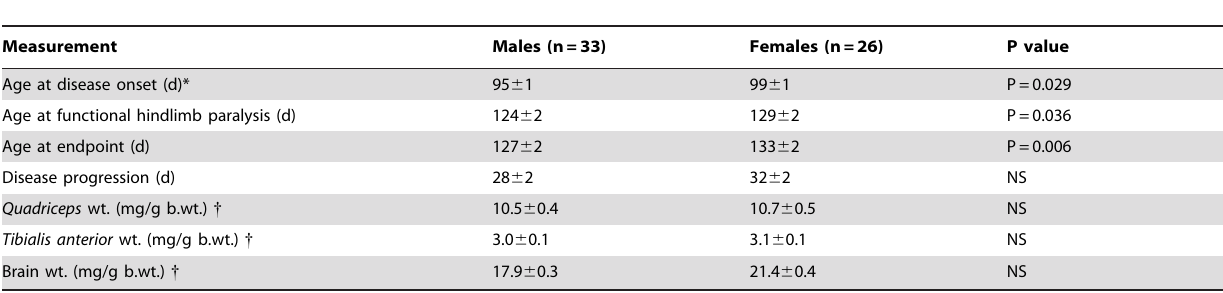
Table 6. Disease outcomes and tissue weight between the sexes in G93A mice.